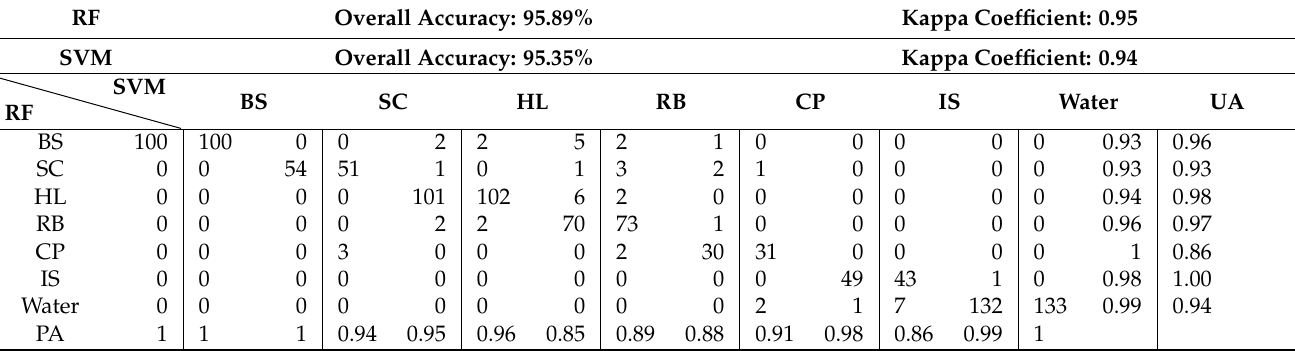
Table 4. Confusion matrix for mangrove classification with combining UAV and WV-2 image samples.